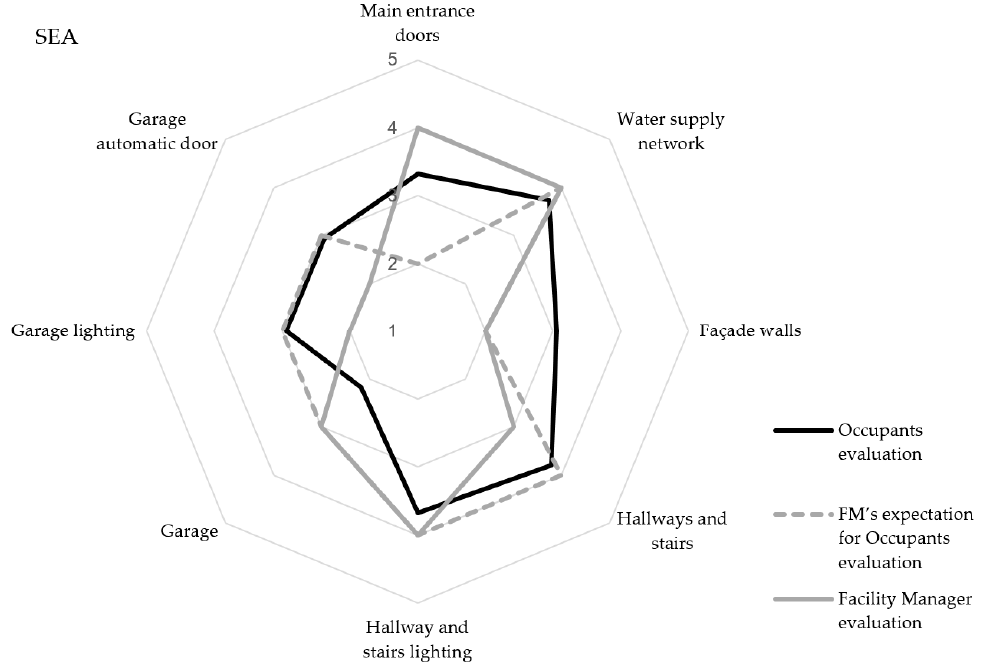
Figure 8. Occupant perception vs. facility manager perception—SEA.